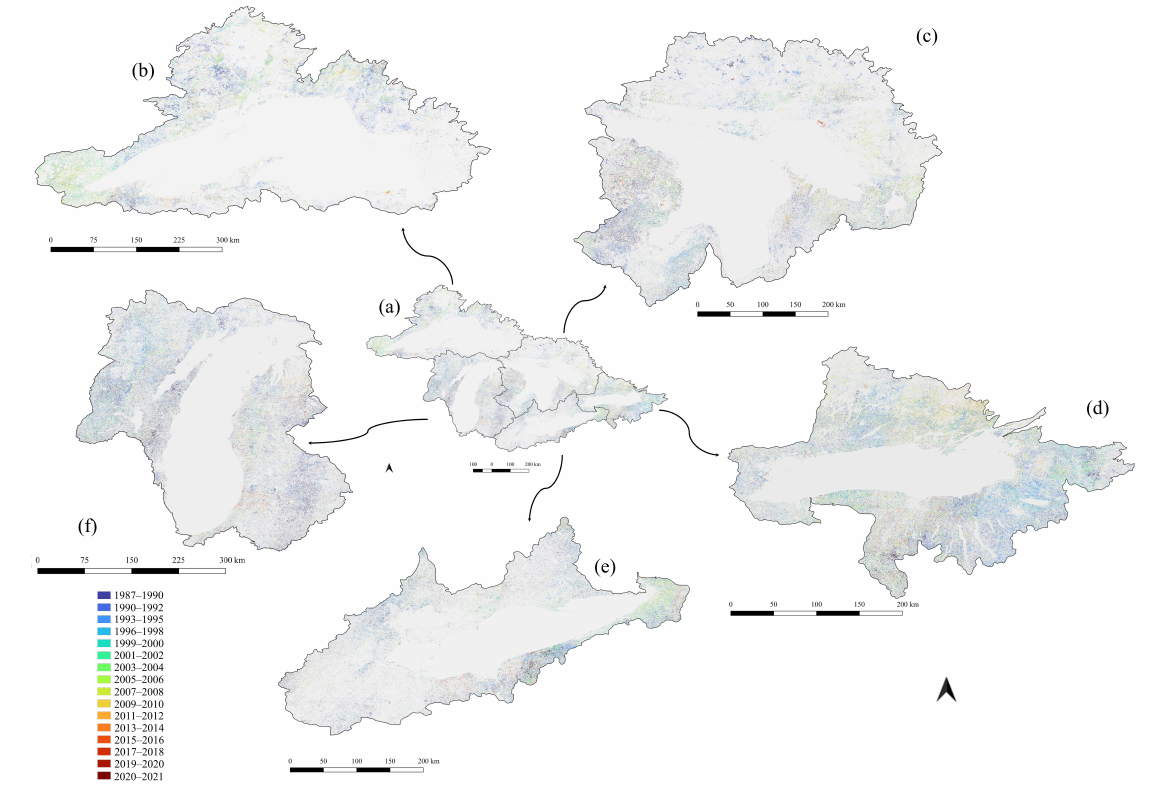
Figure 16. Wetland gain maps of the ( a ) Great Lakes basin and ( b – f ) its subbasins (i.e., Lake Superior, Lake Huron, Lake Ontario, Lake Erie, and Lake Michigan, respectively) at different time intervals.